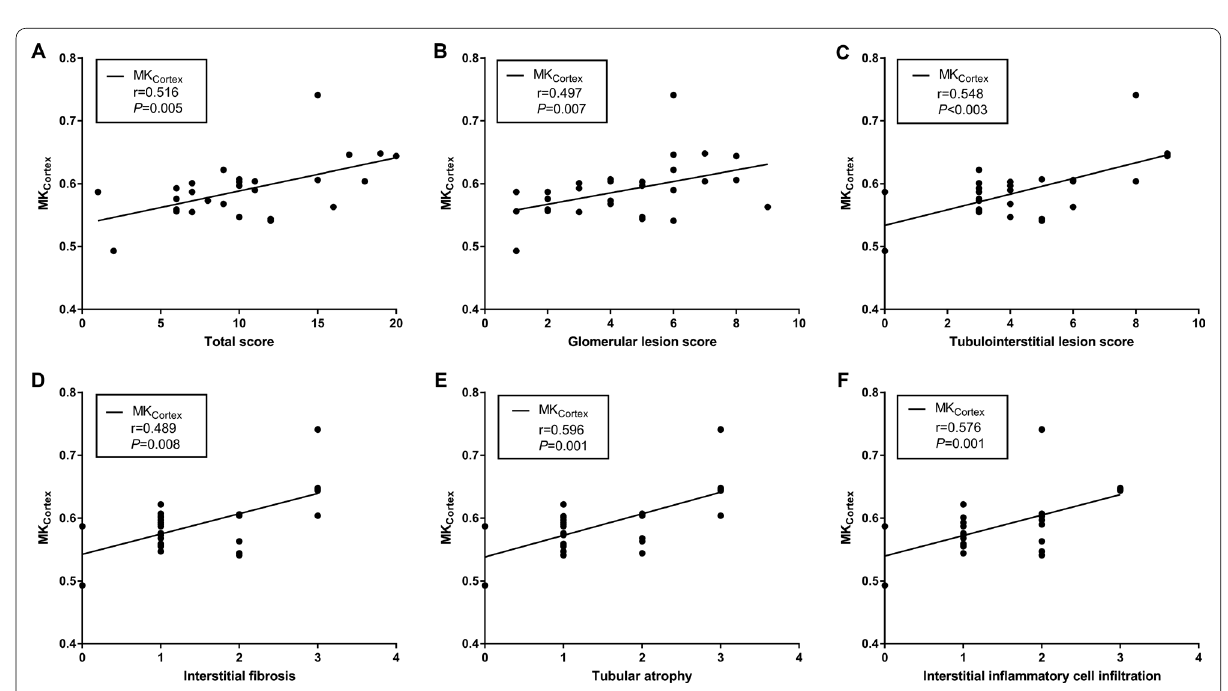
Fig. 7 Correlations between MK Cortex and pathology